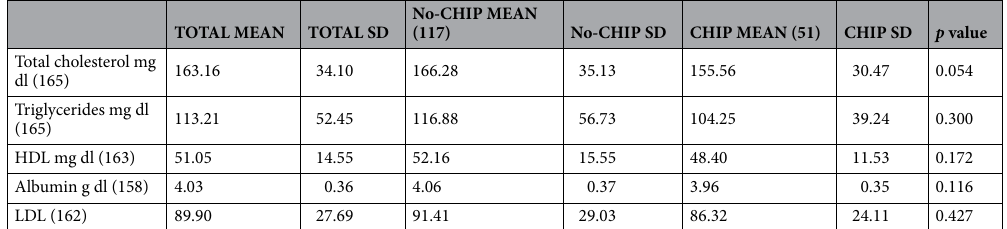
Table 1. Baseline characteristics, echocardiographic and laboratory parameters in patients with and without CHIP. Each column displays the mean or the standard deviation (SD) for the continuous variables of both groups (Total), the No-CHIP or the CHIP samples. For dichotomous variables, the total number of each variable and the percentage of the first one are reported. In the last column, the resulting p-value for each No-CHIP vs CHIP test is shown and the significant ones are written in bold.